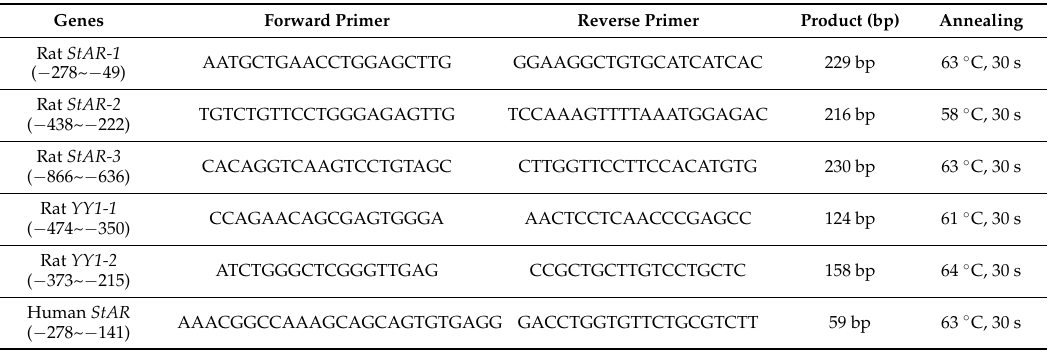
Table 2. Oligonucleotide primers and